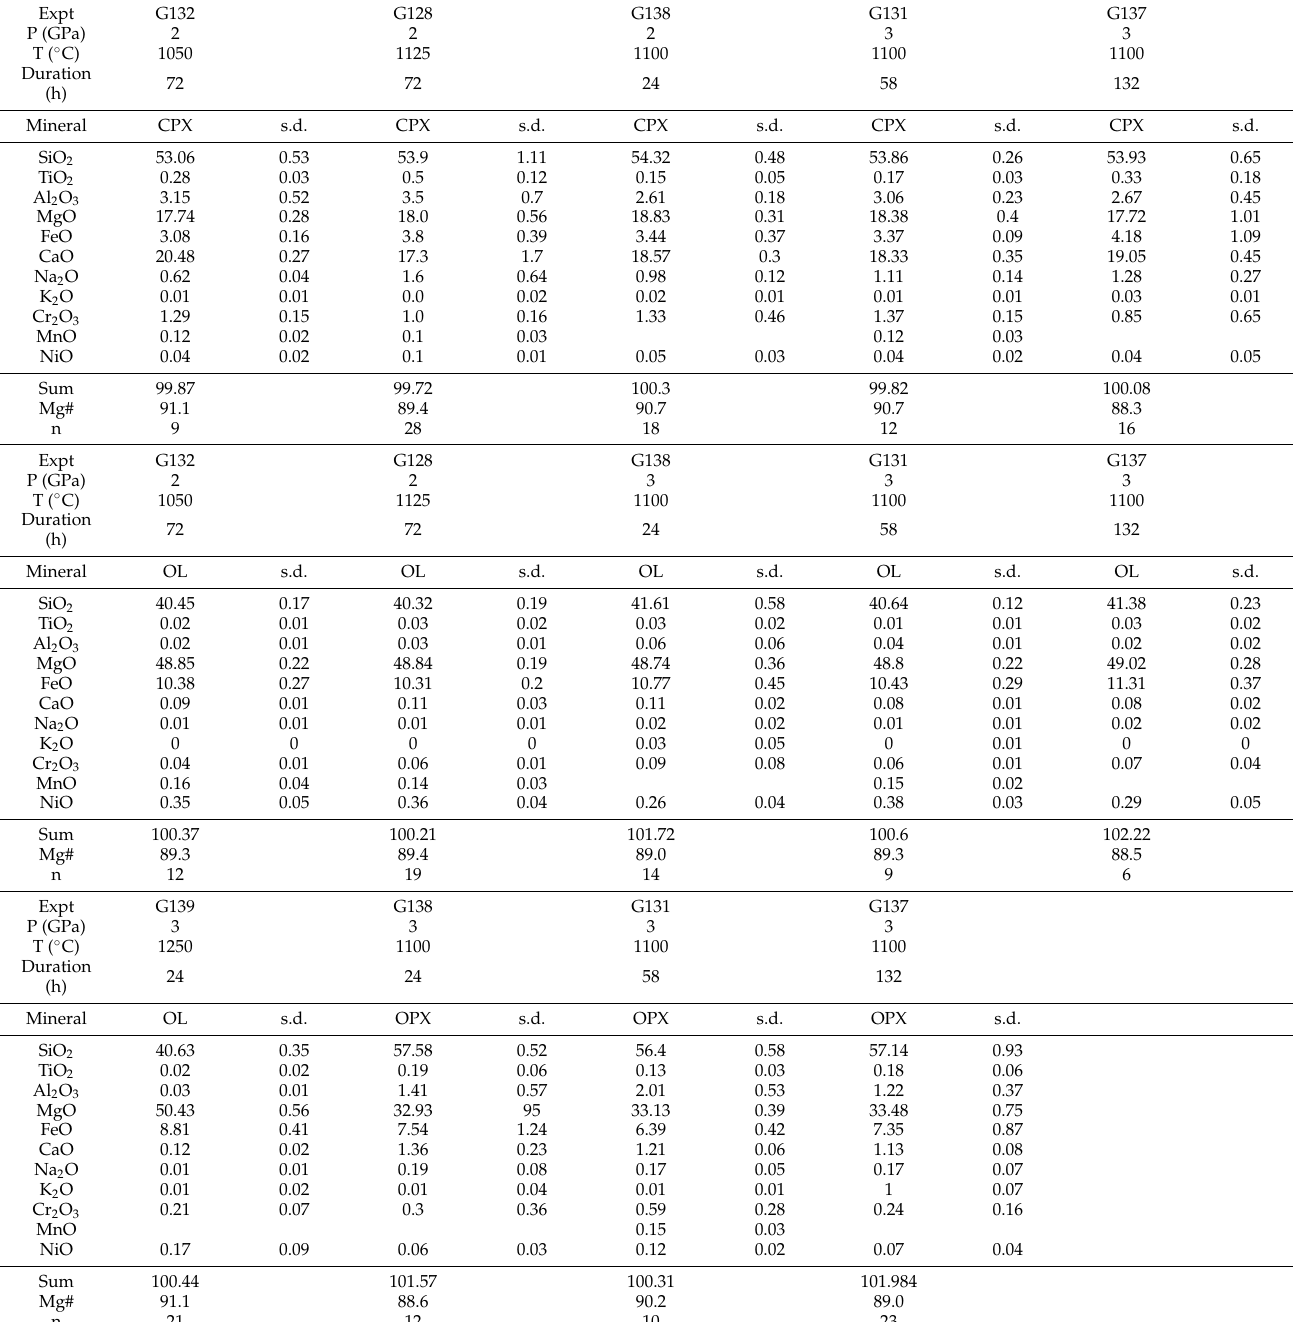
Table 4. Compositions of peridotite minerals in dynamic metasomatism